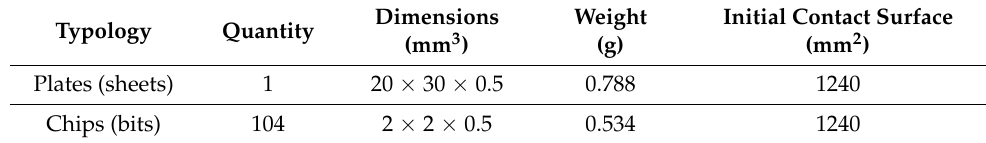
Table 5. A1 plate and chip features.